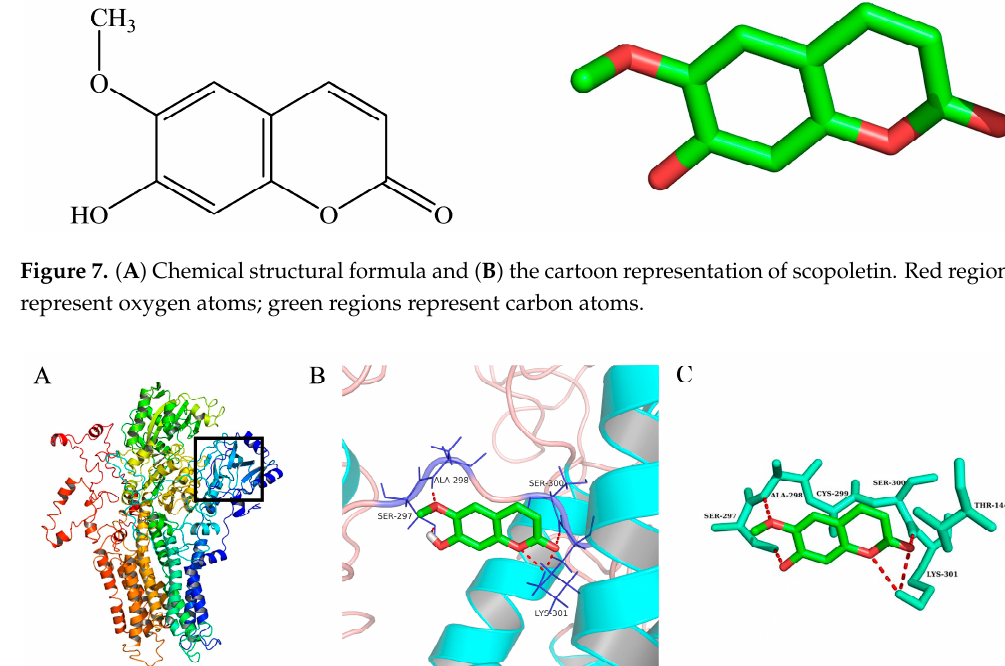
Table 1. Docking results of coumarins with Ca 2+ -ATPase 1 gene of Tetranychus cinnabarinus ( TcPMCA1 ). Compound